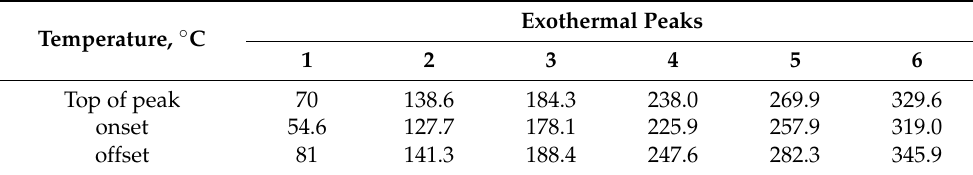
Figure 16. DSC thermogram of solution heat treated 2017 alloy, heated up to 700 ◦ C with a heating rate of 10 K/min. Table 5. Characteristic temperature value of exothermic peaks 1–6 registered on the DSC curve (Figure